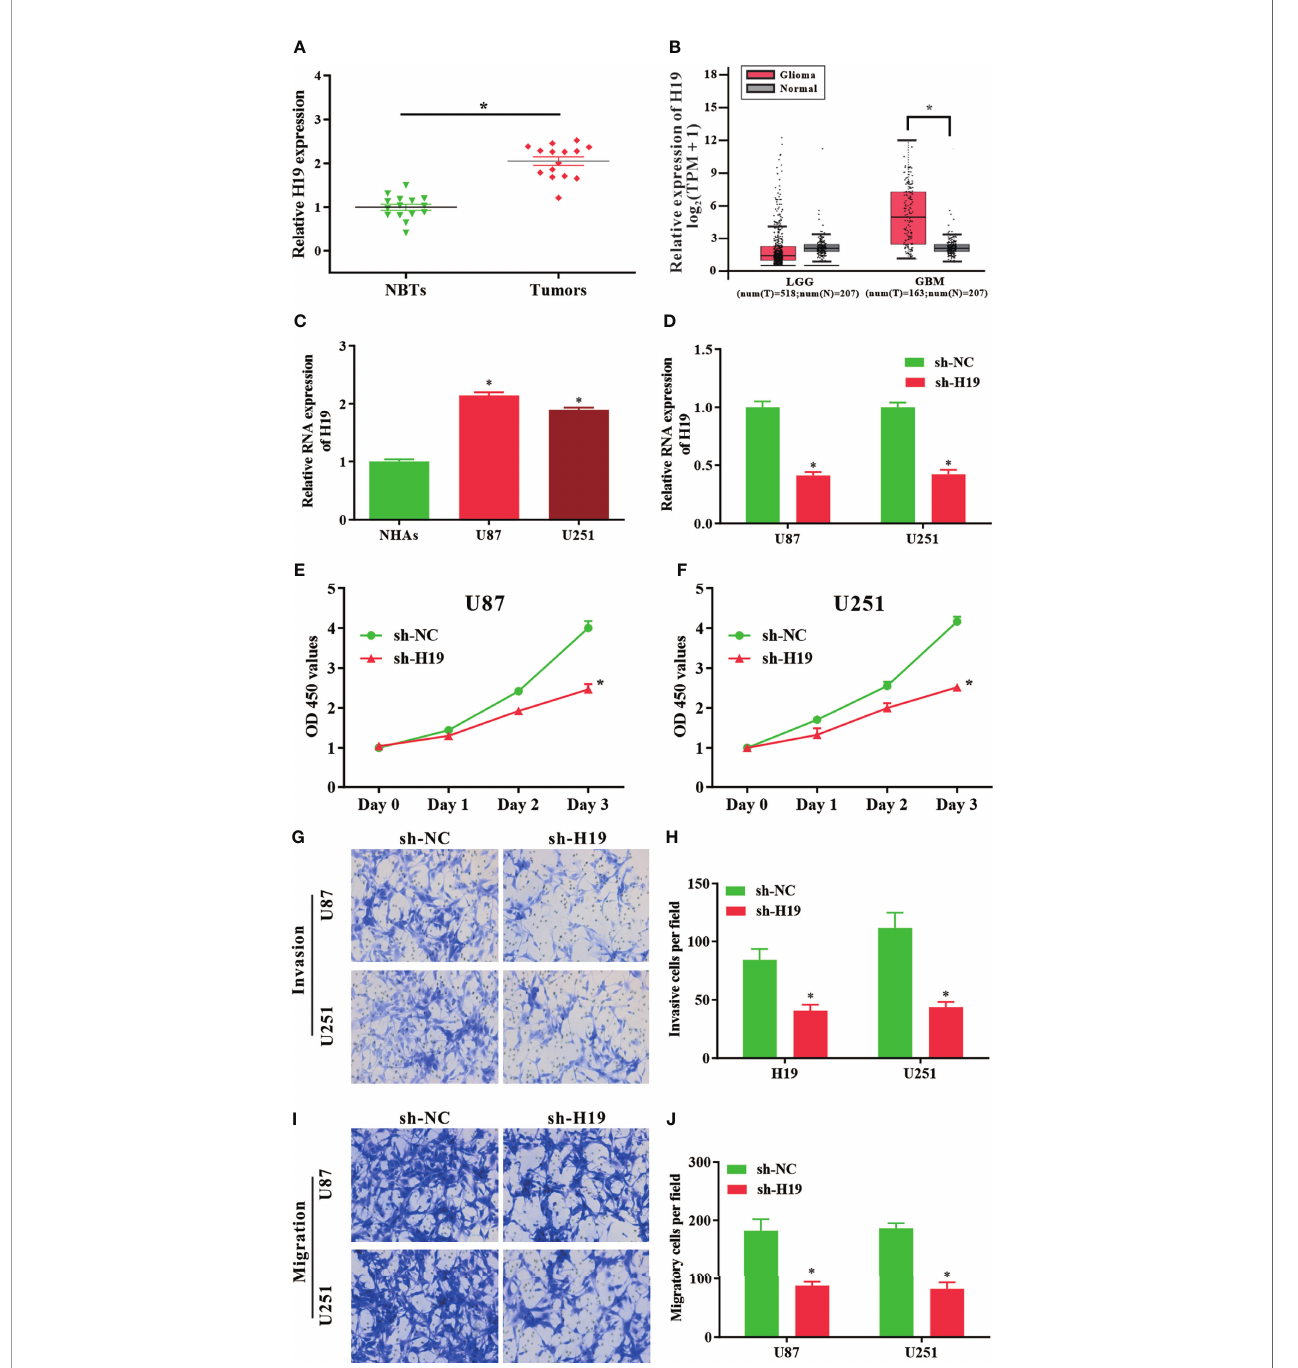
FIGURE 1 | LncRNA H19 is signi fi cantly up-regulated in glioma tissues and cells, and down-regulation of H19 suppresses the proliferation, invasion and migration of glioma cells. (A) The RNA levels of H19 were determined by qRT-PCR. The expression of H19 were remarkably increased in glioma tissues compared with paired para − tumorous controls. (B) Analysis using GEPIA database revealed that H19 expression is signi fi cantly up-regulated in glioma tissues (GBM, T = 163, N = 207). Boxplot illustrated log2 (TPM + 1) on a log-scale; (C) The expression of H19 in NHAs and glioma cell lines (U87-MG and U251). (D) qPCR was performed to evaluate the transfection ef fi ciency of sh-H19 in U87-MG and U251 cells. (E, F) The proliferative activities of U87-MG and U251 cells treated with sh-H19 or sh-NC were examined using CCK-8 assay. (G, H) The invasion of transfected cells were determined by Transwell assay (magni fi cation, x100). (I, J) The migration of U87- MG and U251 cells treated with sh − H19 was also examined using Transwell assay (magni fi cation, x100). Data were presented as mean ± SEM; * P < 0.05 vs NHAs or control group. NHAs, normal human astrocytes; NBTs, normal brain tissues; NC, negative